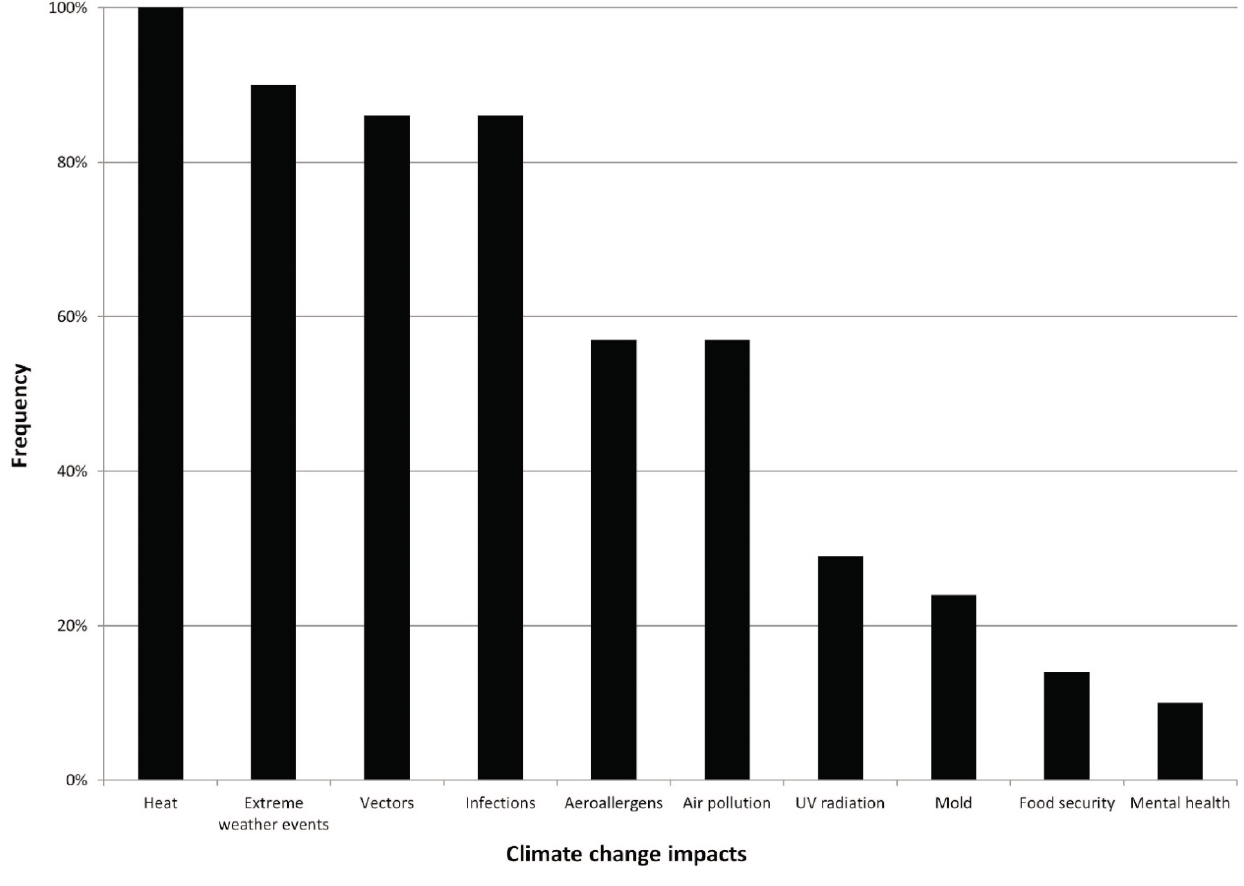
Figure 2. Impacts of climate change on health discussed in strategy documents ranked by frequency of inclusion in strategy documents (more than one impact was mentioned in each document). Heat and extreme weather events were mentioned separately in the texts, as were vectors and other infections. Infections refer to food- and water-borne